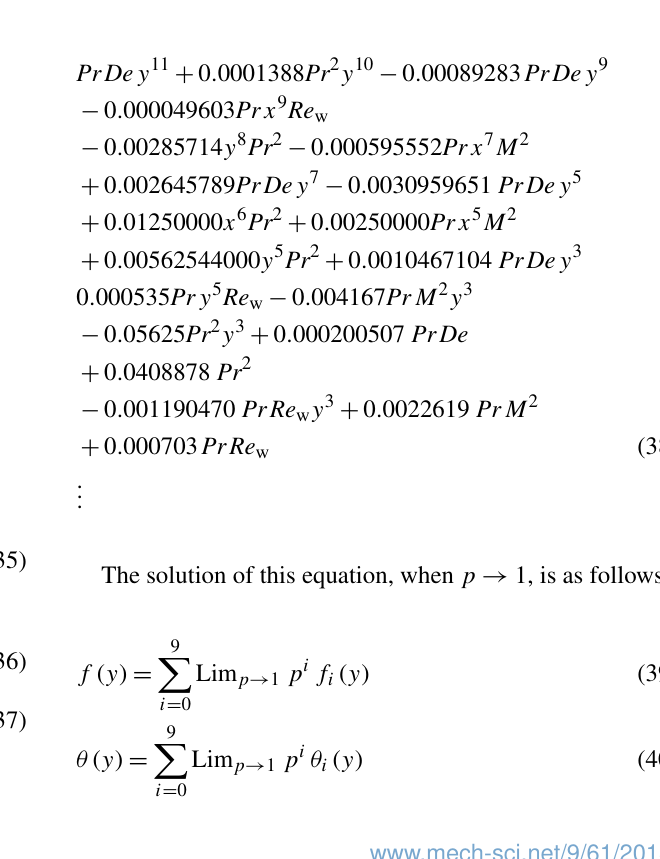
Figure 9. Dimensionless temperature predicted by analytical and numerical method (NUM) for different M Hartman number at De = 0.2, Re w = 2, Pr = 1, (cid:125) = − 1.